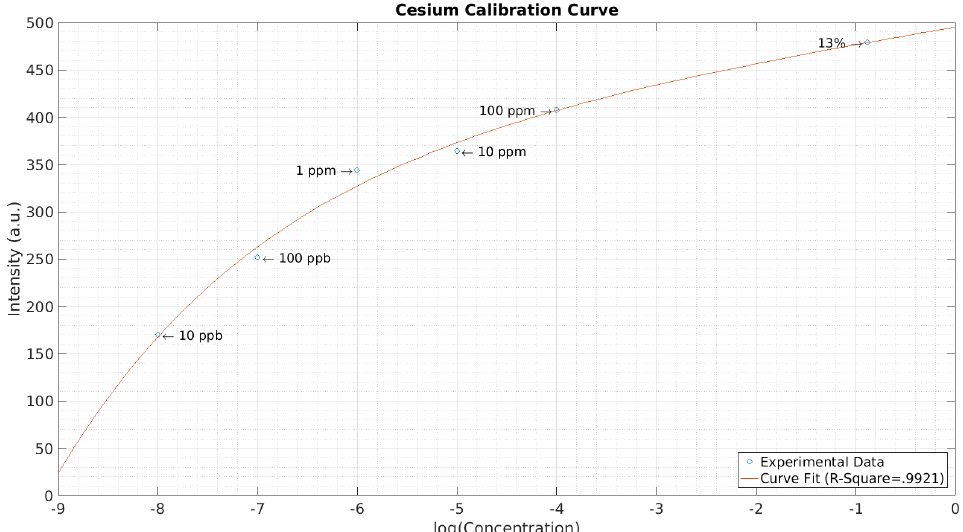
Figure 9. Calibration curve of cesium. The spectral peak at 853.9 nm was